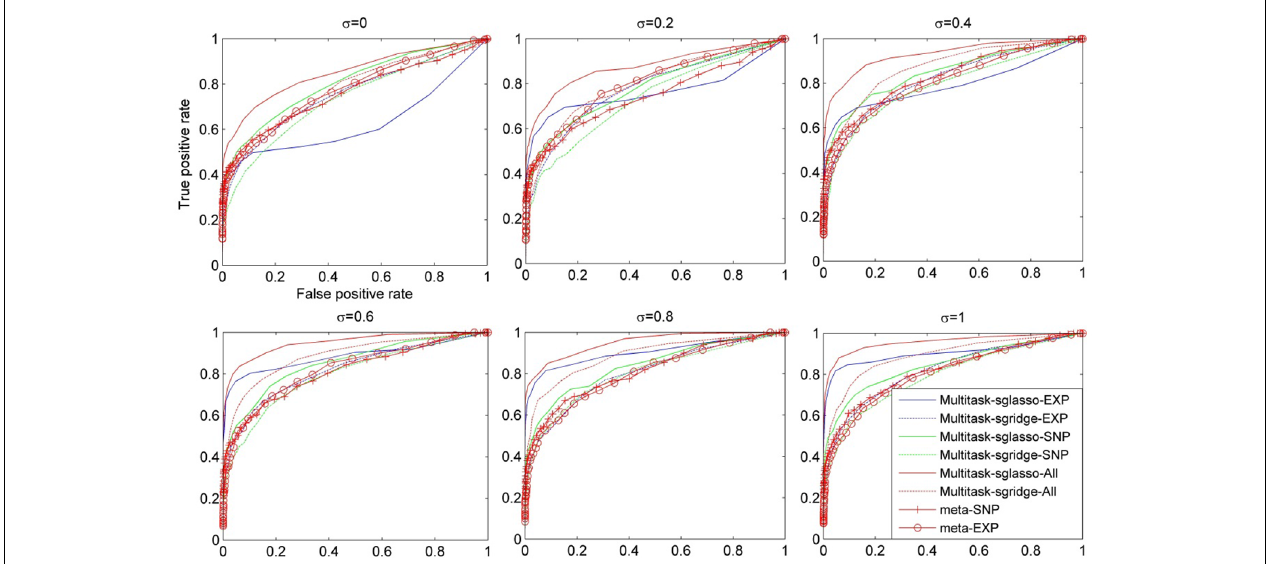
FIGURE 2 | The comparison of eight methods on three SNP and three expression datasets simulated with the dynamic model. The variance of effect size of causal genes is set to normal distribution with variance varying from 0 to 1 at an interval of 0.2.